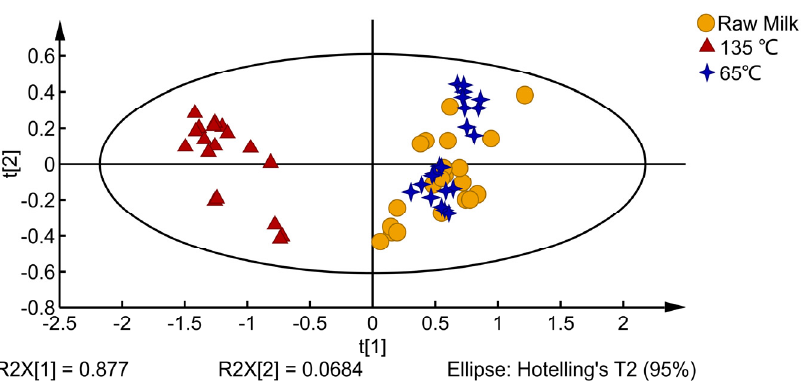
Figure 1. PCA of milk with different processing temperatures.